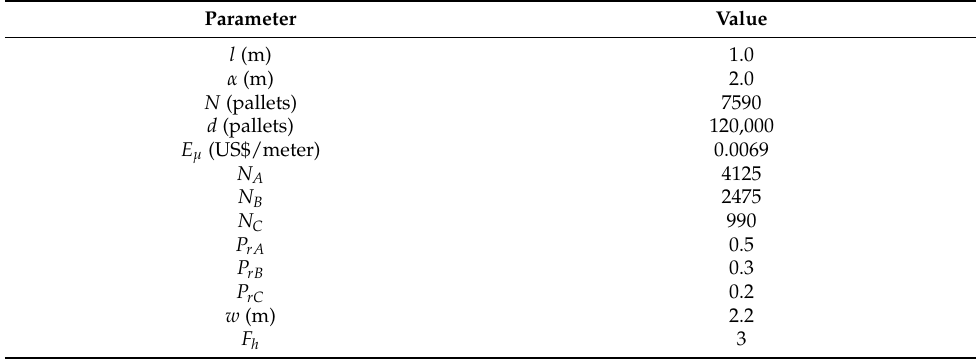
Table 1. Summary of parameters and their values in the water heater factory.